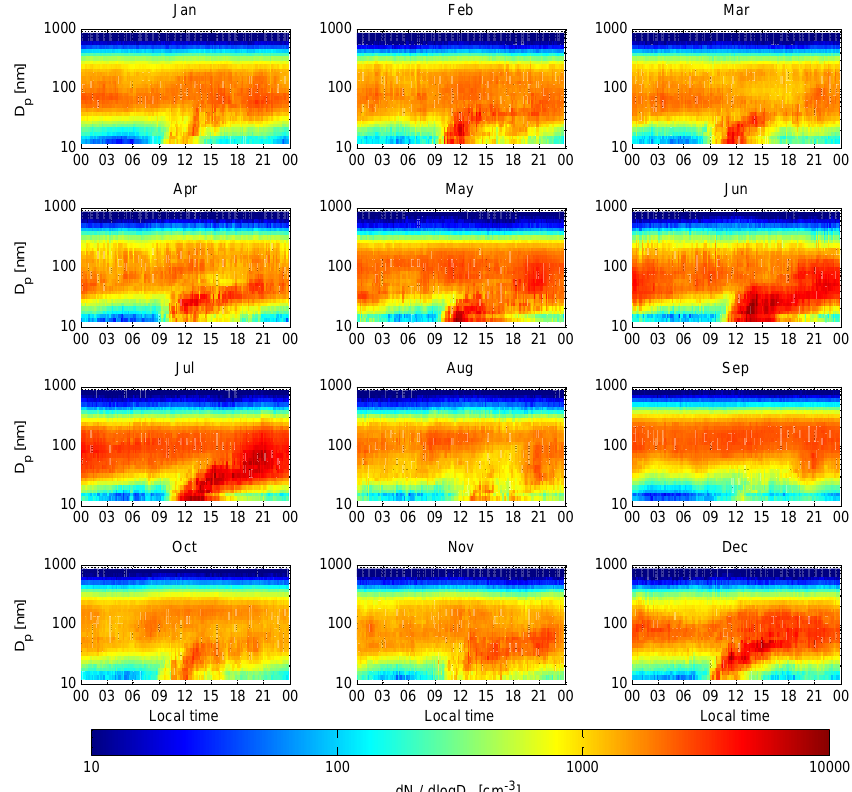
Fig. A1. Botsalano monthly median diurnal